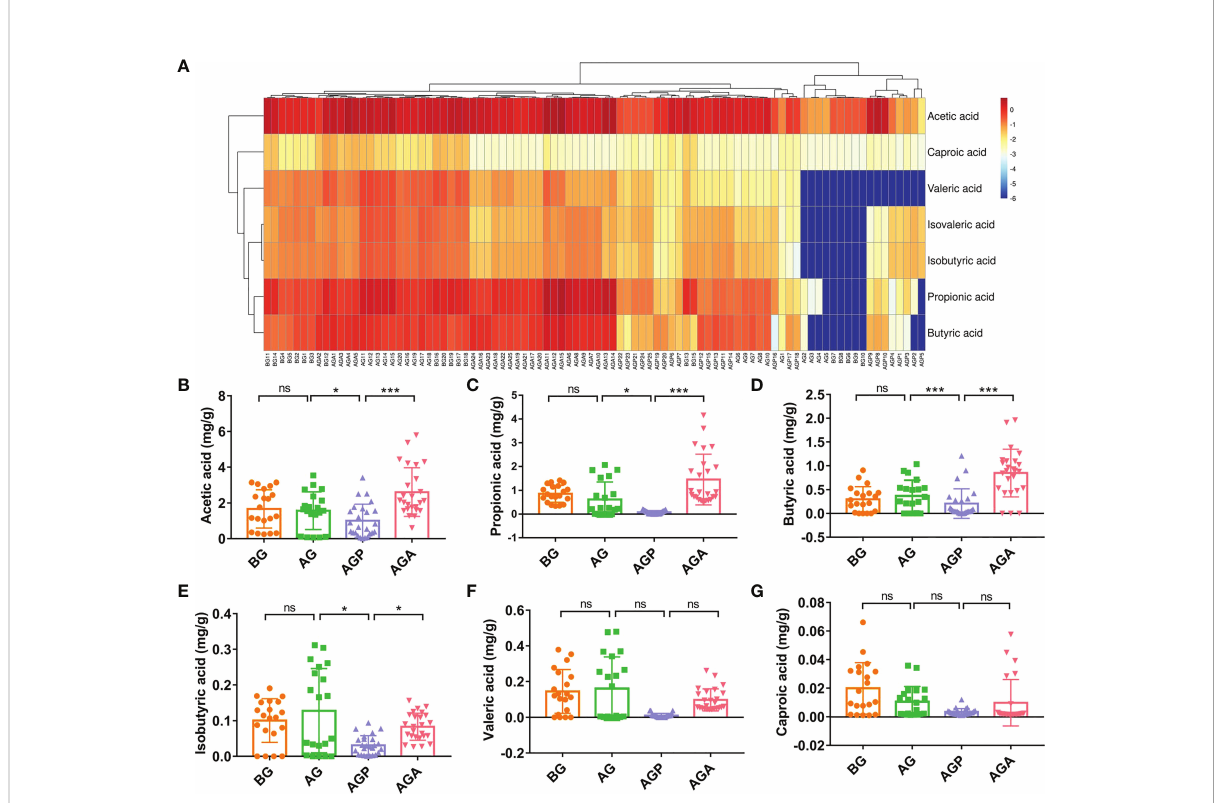
FIGURE 7 C butyricum increased fecal short-chain fatty acid production in patients with gastric cancer after gastrectomy. (A) Heat map of short chain fatty acid; (B) acetic acid; (C) propionic acid; (D) butyric acid; (E) isobutyric acid; (F) Valeric acid; (G) caproic acid. BG, gastric cancer patients before gastrectomy (n=25); AG, gastric cancer patients after gastrectomy (n=25); AGP, gastric cancer patients and treatment with the placebo after gastrectomy (n=45); AGA, gastric cancer patients and treatment with the C butyricum after gastrectomy (n=47). Data are presented as means ±